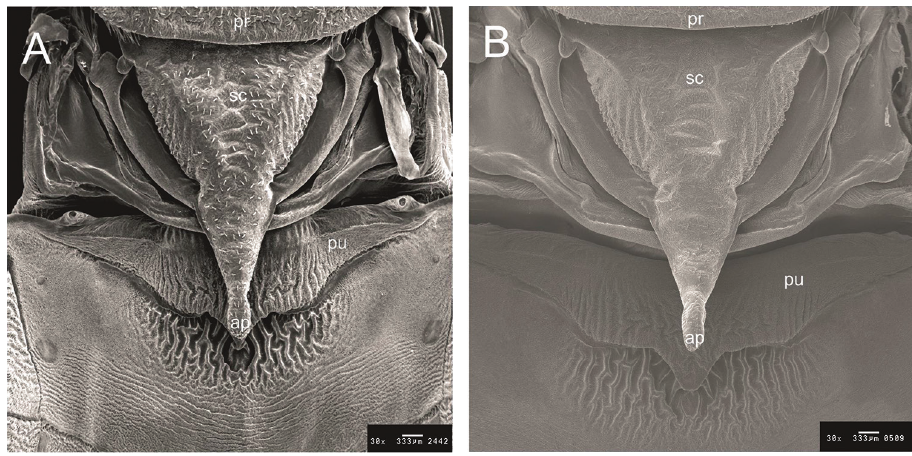
Figure 4. Escutellum and process of I urotergit by SEM. A R. taquarussuensis sp. n. B R. neglectus . pr: pronotum, sc: escutelum, pu: process of I urotergit, ap: apex of